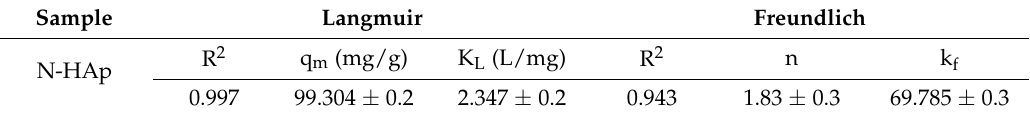
Table 2. Langmuir and Freundlich isotherm parameters for Pb 2+ adsorption onto N-HAp nanopowders.